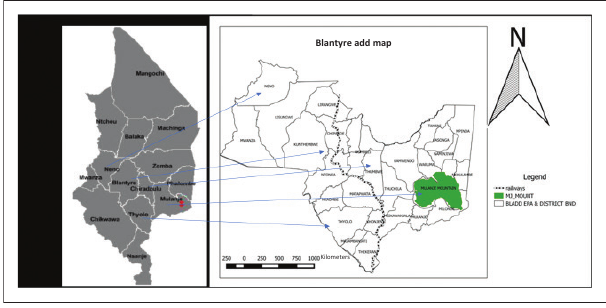
FIGURE 1: Map of the study area (Blantyre Agricultural Development Division in the southern region of